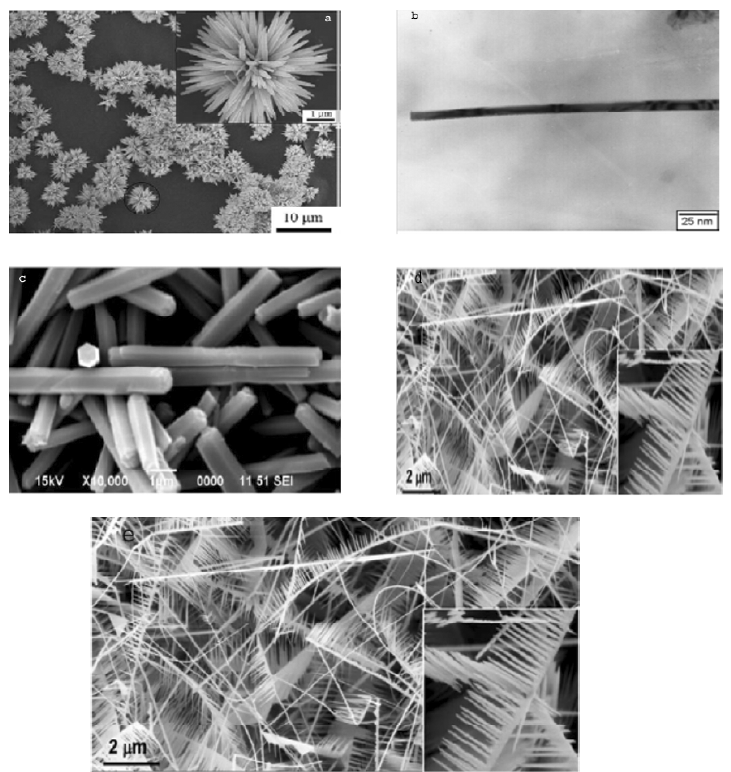
Fig. 1. Different shapes and structures of ZnO, (a) Flower, reprinted with permission from Ref [32], Copy- right 2005 Elsevier,( b) Wire , reprinted with permission from Ref [33], copyright 2007 Elsevier,( c, d) Rod & Mushroom , reprinted with permission from (open access ) Ref [34], copyright 2012 MDPI, (reprinted d) Comb with permission from Ref [35] ,Copyright 2003 American Physical